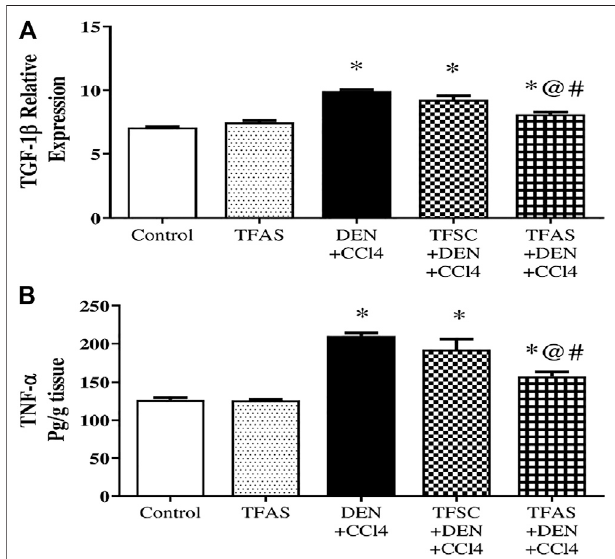
FIGURE 8 | Effect of TF-ODNs on TGF-1 β expression and TNF- α content. Data are expressed as mean ± SEM (n (cid:1) 8). (*), (@) and (#) indicate signi fi cant difference from Control, DEN+CCl4 and TFSC+DEN+CCl4, respectively at P < 0.05 using one-way ANOVA followed by Tukey- Kramer post-Hoc test. TGF-1 β : transforming growth factor beta; TNF- α : tumor necrosis factor alpha; DEN: N-diethyl nitrosamine; CCl4: carbon tetrachloride; TFSC: scrambled tissue factor oligodeoxynucleotides; TFAS: antisense tissue factor oligodeoxynucleotides.